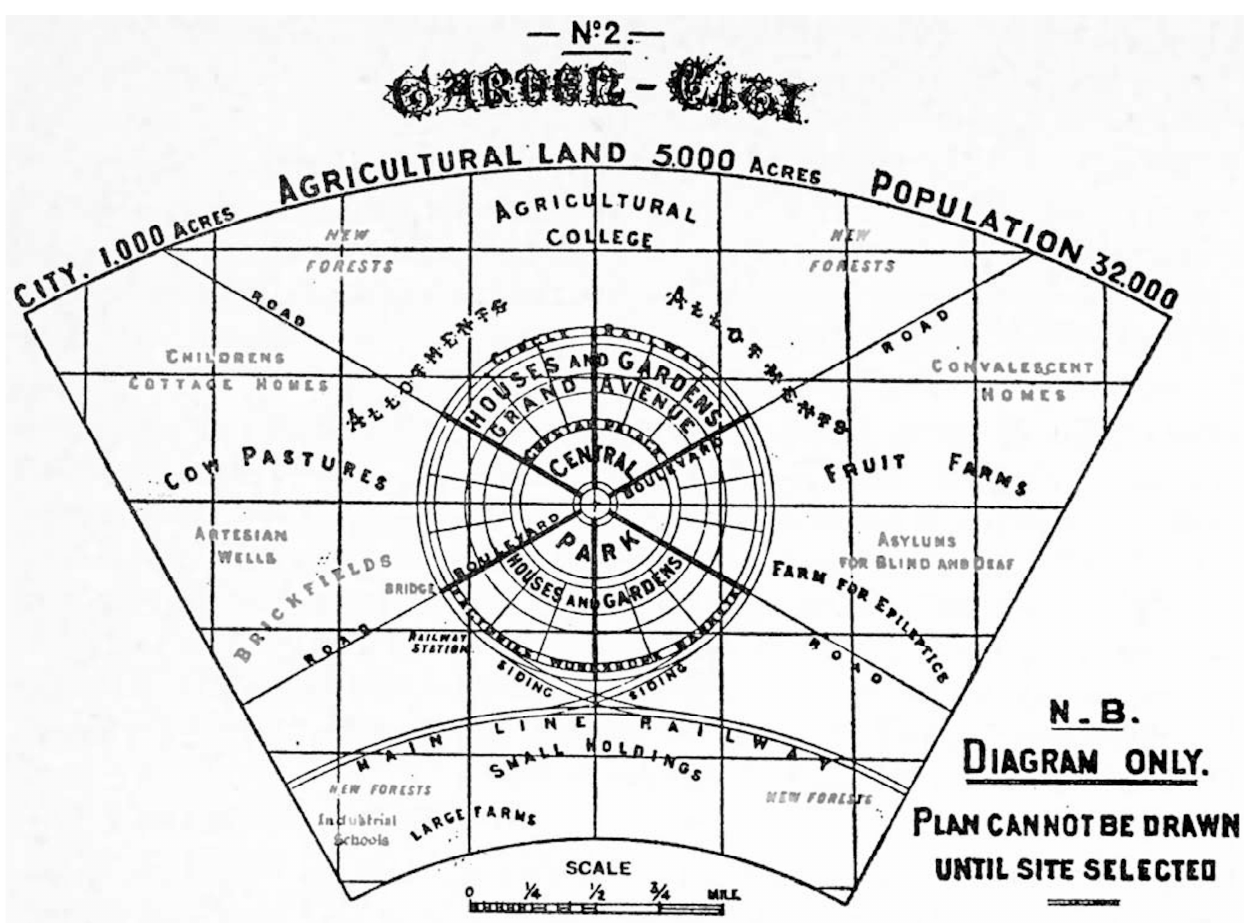
Figure 1. Ebenezer Howard’s Garden City, highlighting a number of agricultural and other land uses in the periurban belt connected to the city. Annotated diagram by Howard (1902). Rather than a dichotomy, Patrick Geddes’ Valley Section laid out a continuum of functionally related and physiographically determined land uses along a continuum from rural to urban. Geddes’ spatial narrative reveals not only the spatial link, but also the sys- temic connections between productive landscapes and the city [11]. Geddes’ cross-section (rather than plan view) lays the conceptual framework for Benton MacKaye, Ian McHarg and others, including contemporary landscape urbanists, to visualize flows of resources as formative agents to be actively engaged in urban planning [12,13]. 3.1.2. Scale and Density of the Productive City Early plans sought to reconnect and recalibrate the scale and density of the city to productive capacity of the land. Thus, metrics and proportions of land to people figure in the schemes. Howard plotted towns of 30,000, rather than large cities or small villages. In this plan, people who lived on one sixth of the land were supported by five sixths of the area cultivated by allotment gardens and smallholder farms. The German designer Leberecht Migge also based his ideal compact village-scale communities on the capacity of individual gardens and smallholders [14]. The scale and density of Le Corbusier’s 1922 Contemporary City proposal for a pop- ulation of three million is exponentially larger in scale, with people supported by three food-producing zones: “protected zones” for large scale agriculture, large kitchen gardens for detached suburban homes, and 10-acre groups of allotments cultivated by apartment